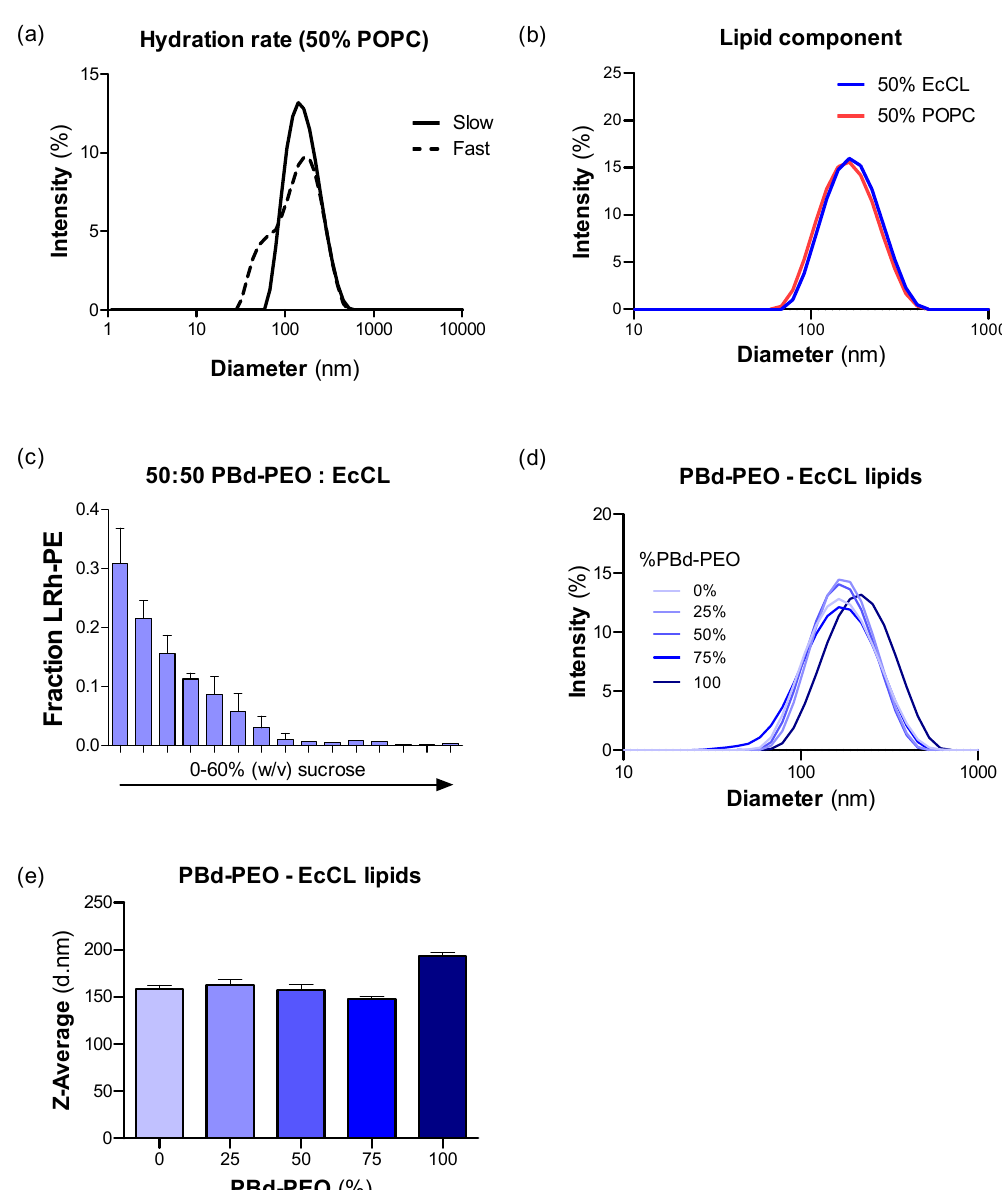
Figure 1. Physical features of hybrid polymersomes analysed using dynamic light scattering (DLS). ( a ) Hybrid vesicles comprising 50 mol% palmitoyl-oleoyl-phosphatidylcholine (POPC) and 50 mol% poly (butadiene)-poly (ethylene oxide) (PBd-PEO) were hydrated in buffer using two methods. The fast hydration involved vigorous stirring and heating to resuspend the lipid film. Slow hydration involved gentle stirring of the film in buffer over 48 h. DLS intensity profiles are shown for slow ( solid ) and fast ( dashed ) protocols. ( b ) DLS intensity profiles are shown for hybrid vesicles containing 50 mol% PBd-PEO. The remaining proportion comprised either POPC ( red ) or the crude E. coli lipid extract and cholesterol (EcCL) lipid mixture ( blue ). ( c ) The buoyancy of hybrid vesicles containing 50 mol% PBd-PEO and 50 mol% of EcCL lipid was measured in a sucrose density gradient. Vesicles contained 0.1 mol% of probe lipid L- α -phosphatidylethanolamine-N-(lissamine rhodamine B sulphonyl) (Rh-PE) to monitor their distribution through the gradient by fluorescence detection ( λ ex = 560 nm and λ em = 583 nm). ( d ) DLS intensity profiles are shown for hybrid vesicles containing varying proportions of PBd-PEO and the crude EcCL lipid mixture. ( e ) The Z-average of the intensity profiles was used to estimate the hydrodynamic size of the vesicles shown in panel ( c